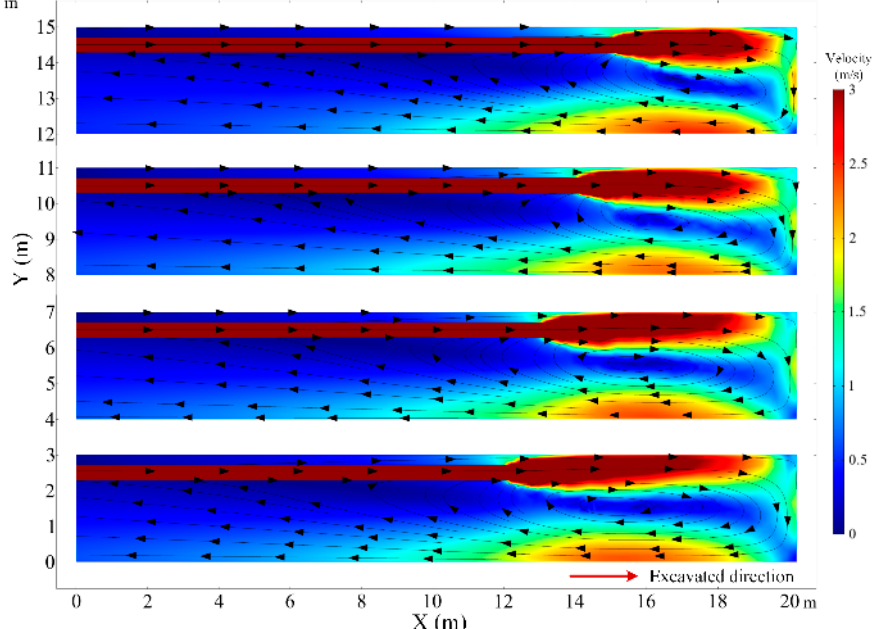
Figure 11. Airflow velocity distribution in Z = 1.0 m plane under different distance between duct outlet and working face.